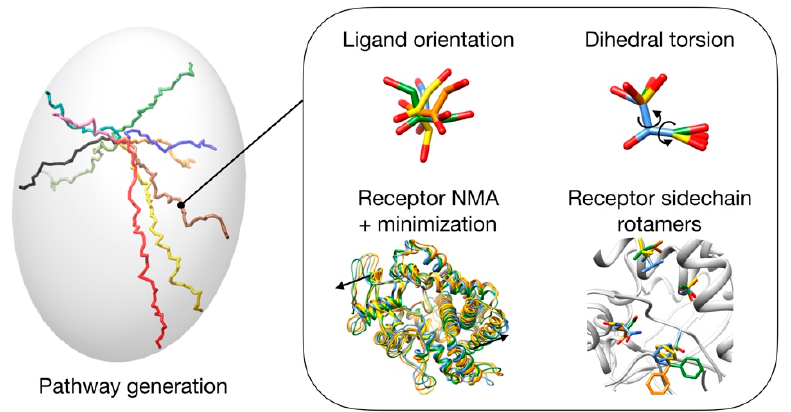
Figure 8. Scheme of di ff erent options (genes) that can be used to generate possible solutions.